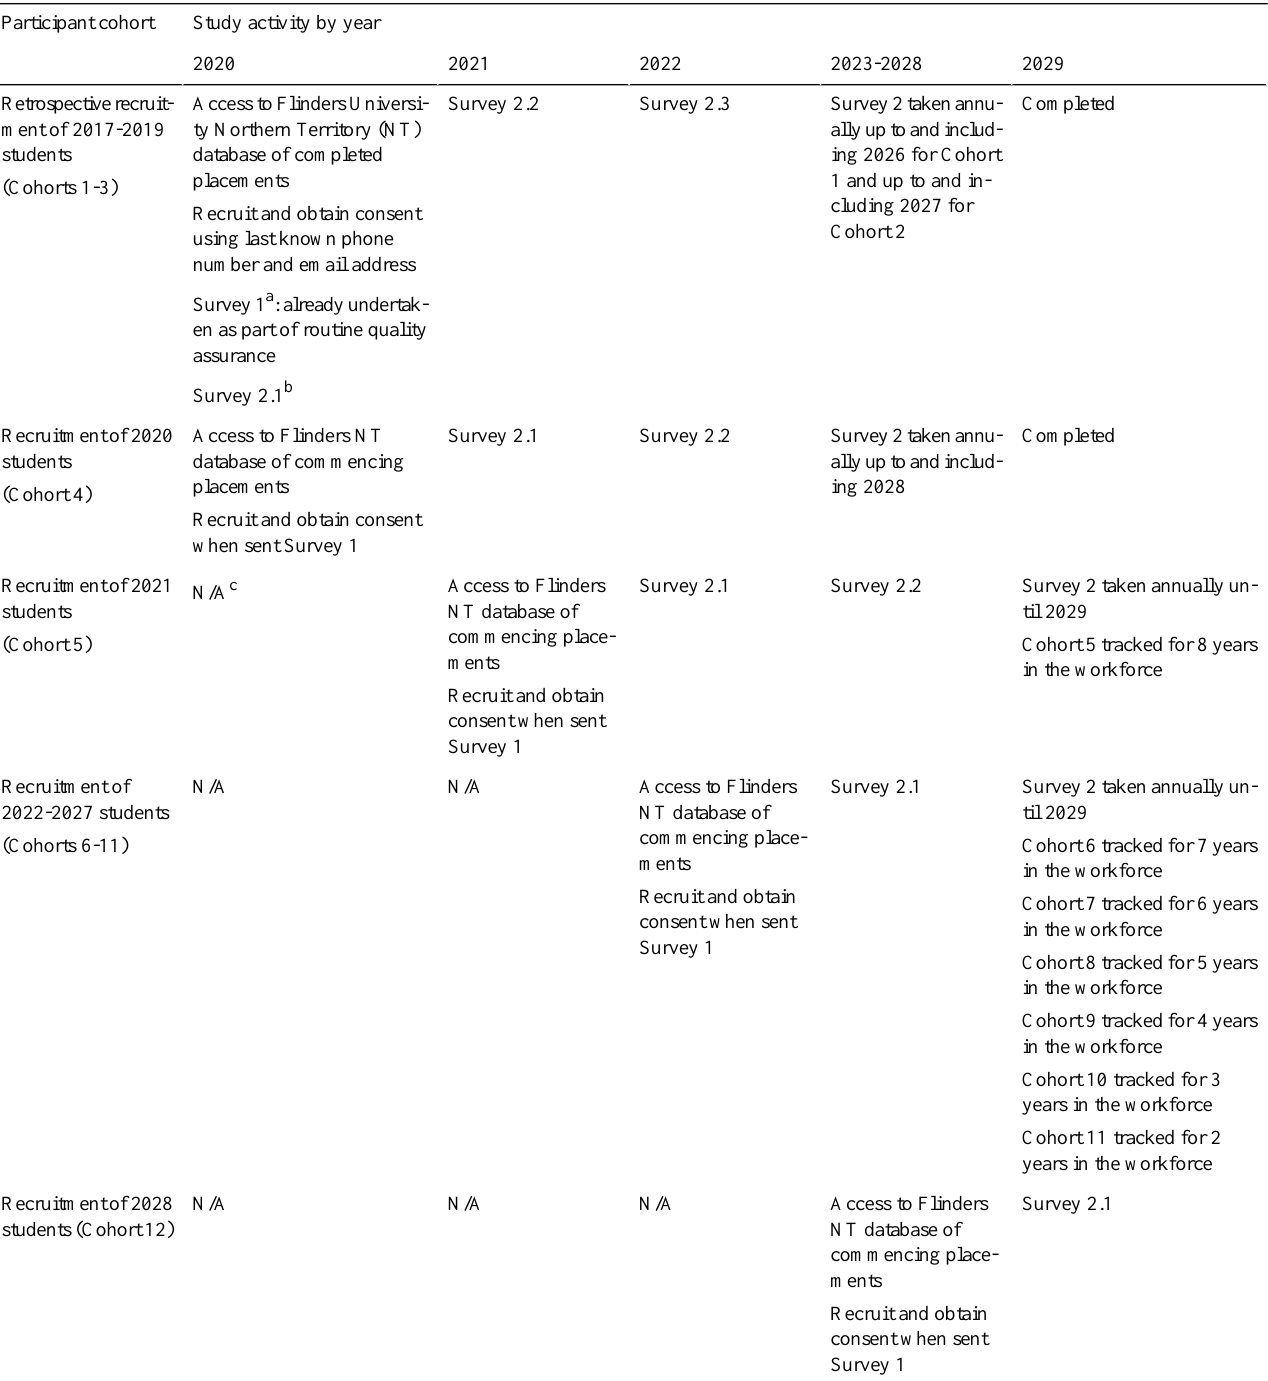
Table 1. Study design showing timing of recruitment and data collection. Study activity by yearParticipant